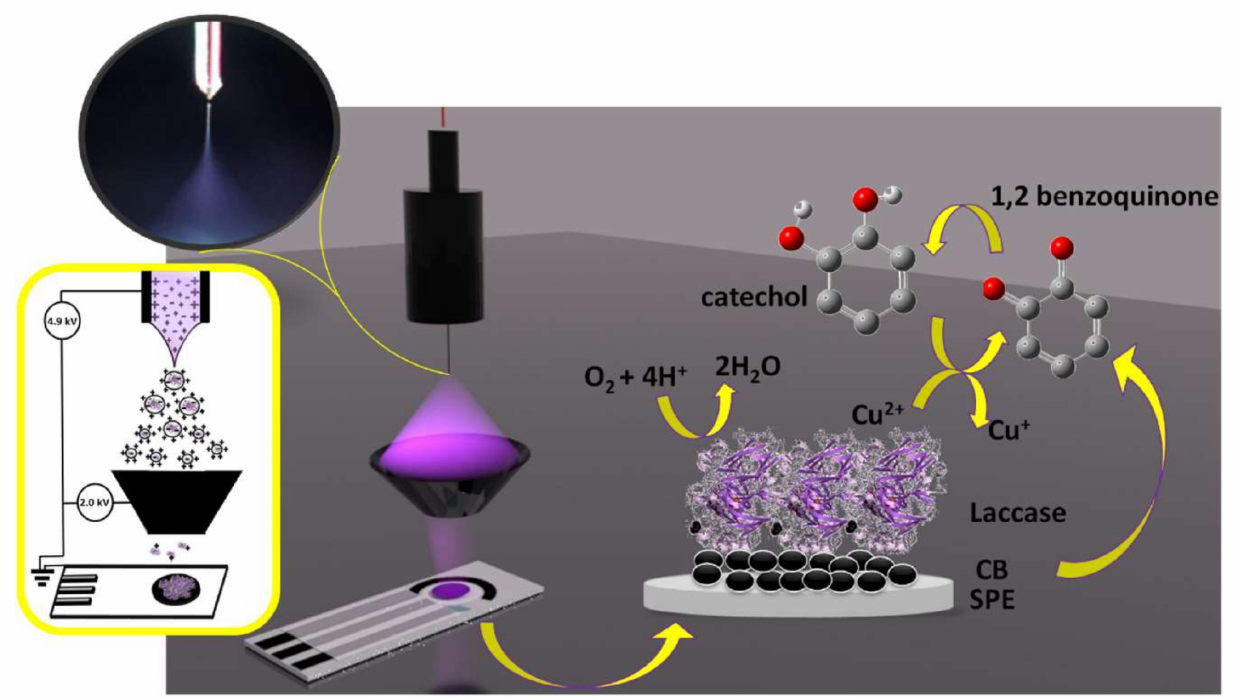
Figure 9. The schematic presentation of the application of ESI-based laccase biosensor development. This figure and its caption were adapted from Castrovilli et al., 2020 [83] with permission from Elsevier, Amsterdam, The Netherlands (License number 5218690964733). On the left side, the electrospray deposition (ESD) of the setup used for laccase immobilization on carbon black modified screen-printed electrodes; in the inset, a picture of the Taylor cone recorded by the camera during a deposition run. On the right side, the laccase catalytic action to catechol oxidation and oxygen reduction is underlined by the